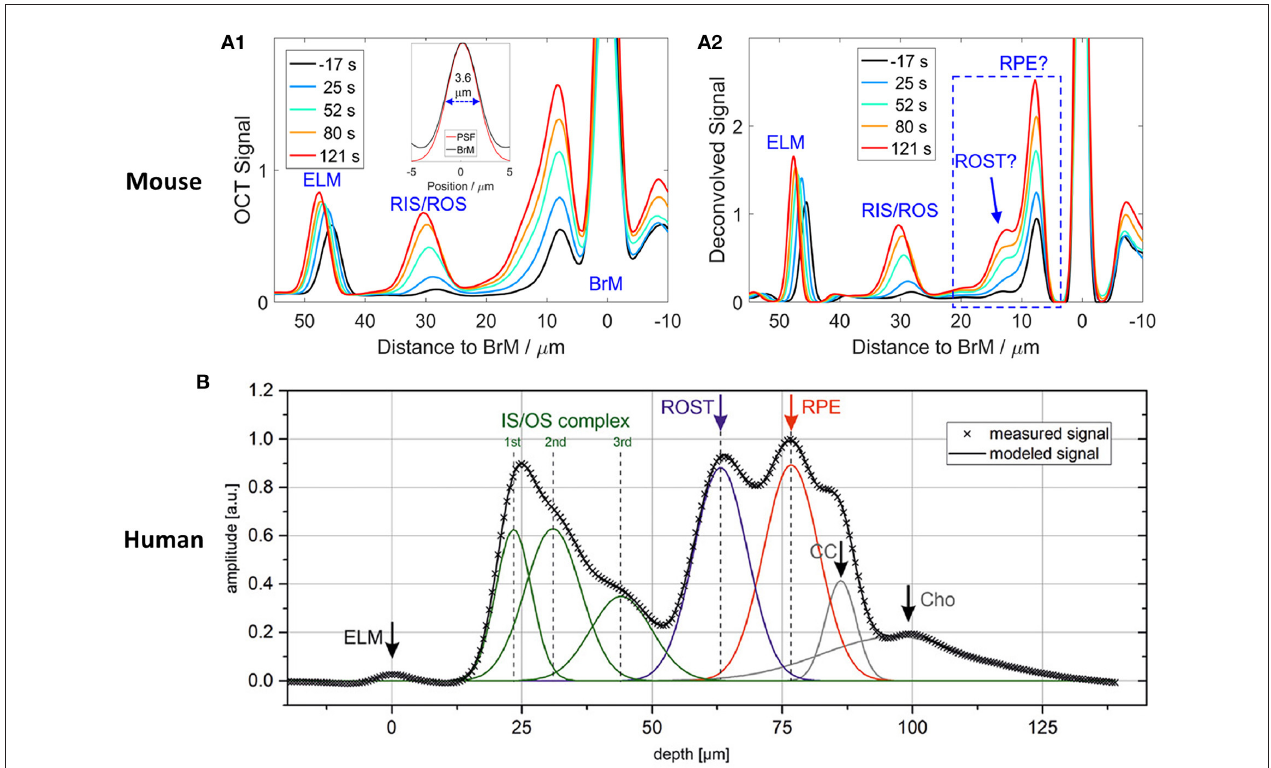
FIGURE 3 | Representative OCT hyper-reflective band analysis. (A) Deconvolution method. (A1) Depth scattering profiles of the retina of an albino mouse. (A2) Deconvolution analysis reveals that the backscatter band nearest to Bruch’s membrane (BrM) on the anterior side comprises two distinct components (question marks are used to indicate that the assignment to structures required confirmation). Reprinted with permission from Zhang et al. (35). (B) A-line signal modeling by summation of seven Gaussian curves. Gray crosses represent the measured data points, and the black line is the summation of the individual model curves (green, blue, red, and gray lines). ELM, external limiting membrane; IS/OS, inner segment/outer segment complex; ROST, rod outer segment tips; RPE, retinal pigment epithelium; CC, choriocapillaris; Cho, choroid. Reprinted with permission from Messner et al. (